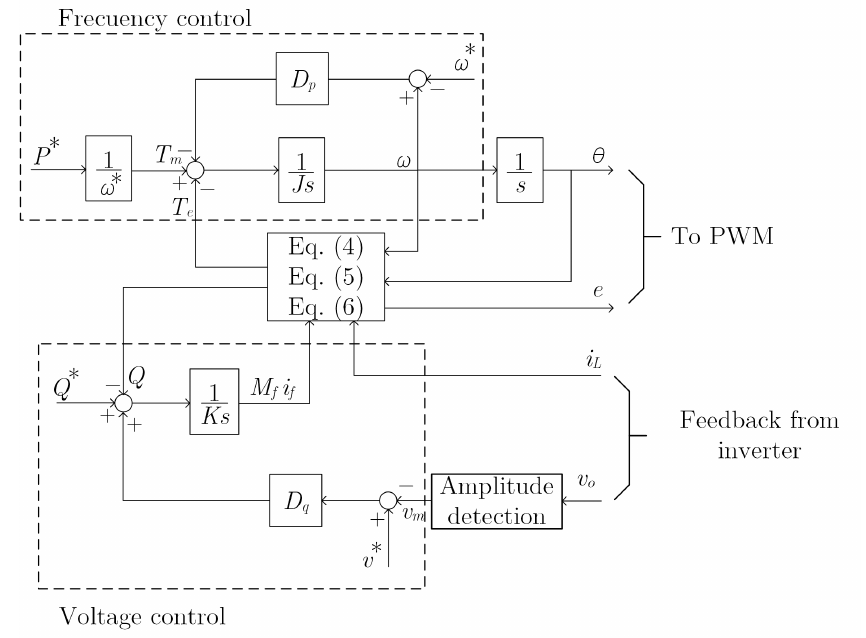
Figure 2. Electronic part of the synchronverter